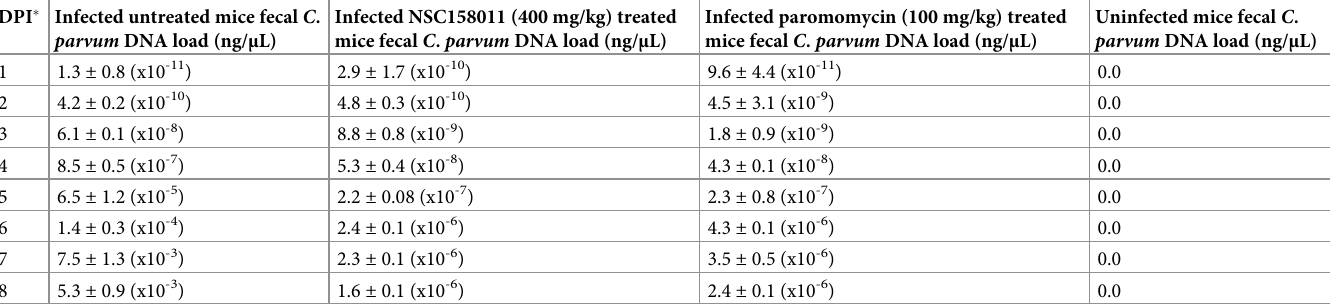
Table 4. Real-time PCR quantification of C . parvum DNA in fecal samples of treated or untreated infected mice. DPI � Infected untreated mice fecal C .